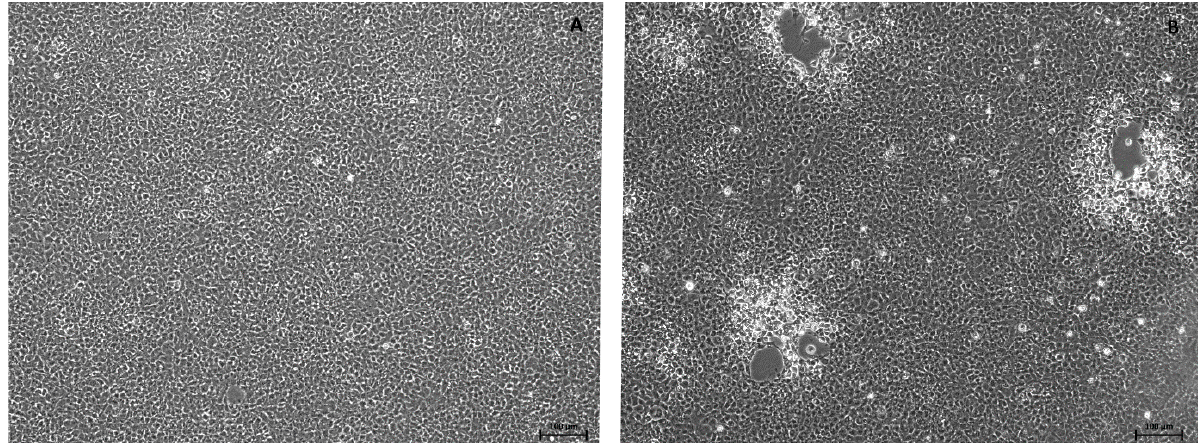
Figure 4. The first three dead wels catfish from Experiment (A) were dissected immediately for virus re-isolation. The ECV was successfully isolated from all of them. ( A ): the control EPC cells and ( B ): the CPE caused by the ECV 48 h after the inoculation with the sample originating from the first dead fish.